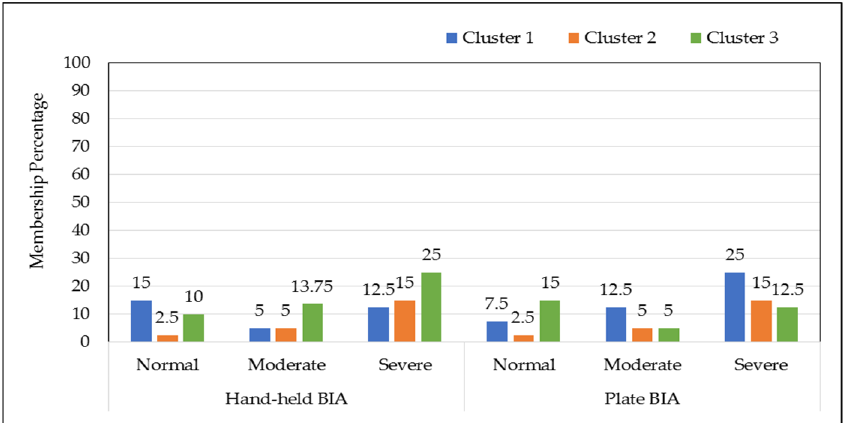
Figure 4. Membership cluster percentage formed in fuzzy c means analysis for different BIA set-ups.